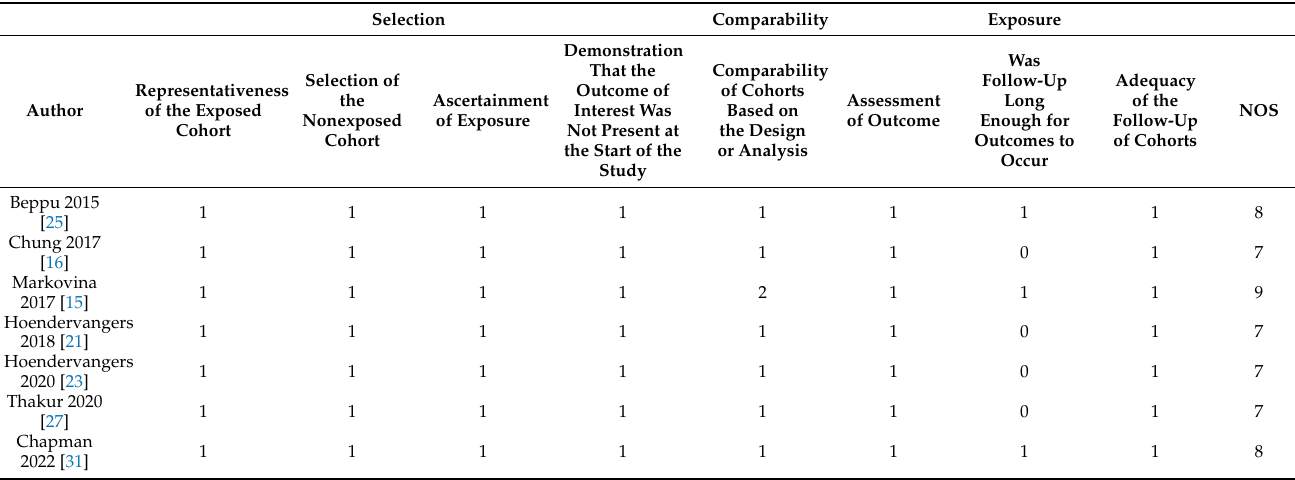
Table 2. Scores of the observational studies according to the Newcastle-Ottawa Scale.